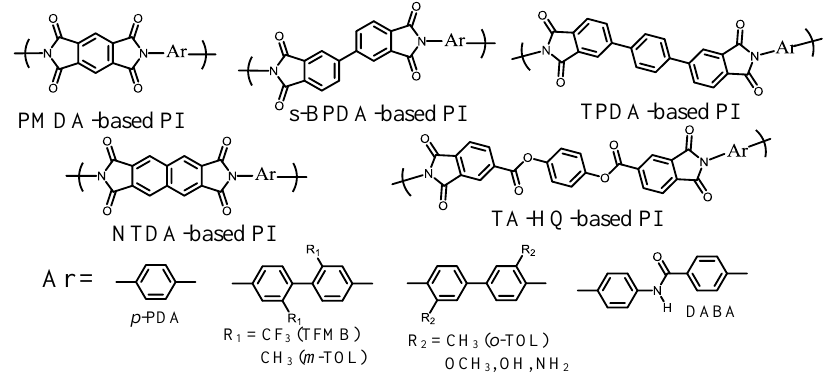
Figure 6. The structures of aromatic PI systems leading to low-CTE property by two-step method. PMDA = pyromellitic dianhydride, TPDA = 3,3″,4,4″- p -terphenyltetracarboxylic dianhydride, NTDA = 2,3,6,7-naphthalenetetracarboxylic dianhydride, TA-HQ = hydroquinone bis(trimellitate anhydride), p -PDA = p -phenylenediamine, m -TOL = m -tolidine, o-TOL = o -tolidine, DABA = 4,4′- diaminobenzanilide. Table 1. Salt formation behavior in the PAA polymerization and selected properties of PI films for the systems that we have investigated so far.